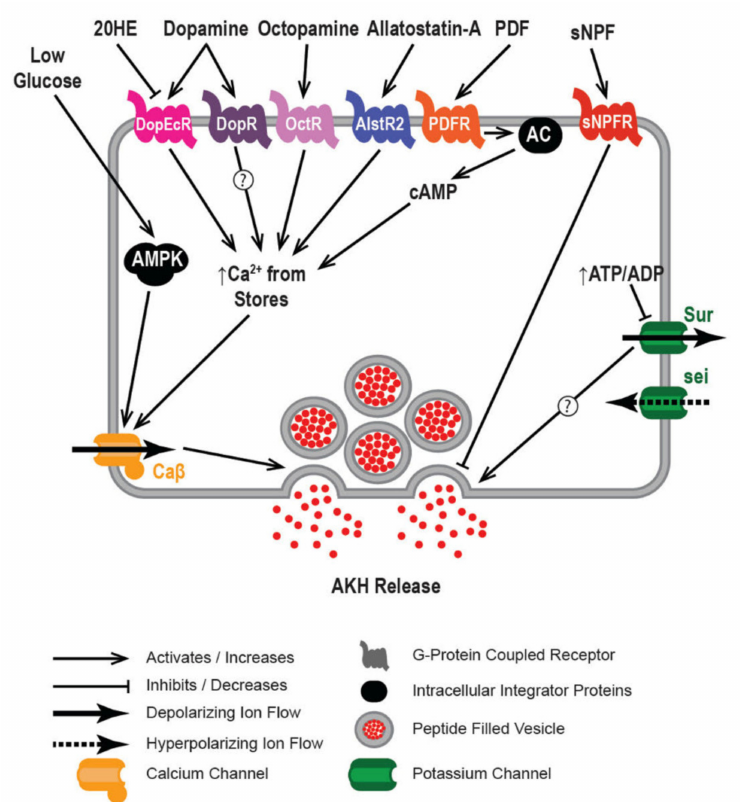
Figure 4. Model of APC physiology. (Top) AKH cells receive hormonal input via GPCRs. Dopamine leads to the activation of multiple dopamine receptors present in AKH cells. These receptors in turn directly lead to the influx of calcium in a sugar dependent manner. Ecdysone application blocks dopamine-dependent responses. PDF acts on AKH cells via PDFR and in turn leads to increased production of cAMP through an unidentified adenylate cyclase. Presumably increases in cAMP modulate calcium influx. (Middle) AMPK is activated by low sugar and in turn leads to calcium influx. (Bottom) AKH cells express multiple ion channels that regulate membrane excitability. Notably the Sur subunit of K + ATP channels responds to changes in cellular ATP. Ca-Beta is a regulatory subunit of the functional calcium channel. sei modulates potassium influx and baseline membrane